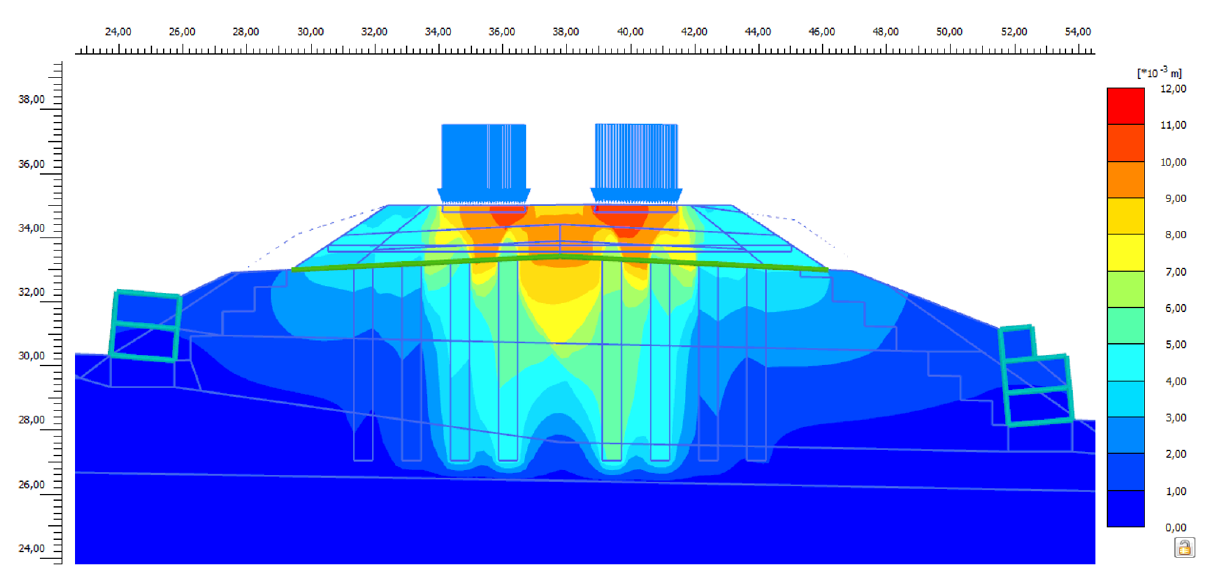
Figure 5. Isolines of computed total deformations caused by a traffic loading of intensity 80 kN/m